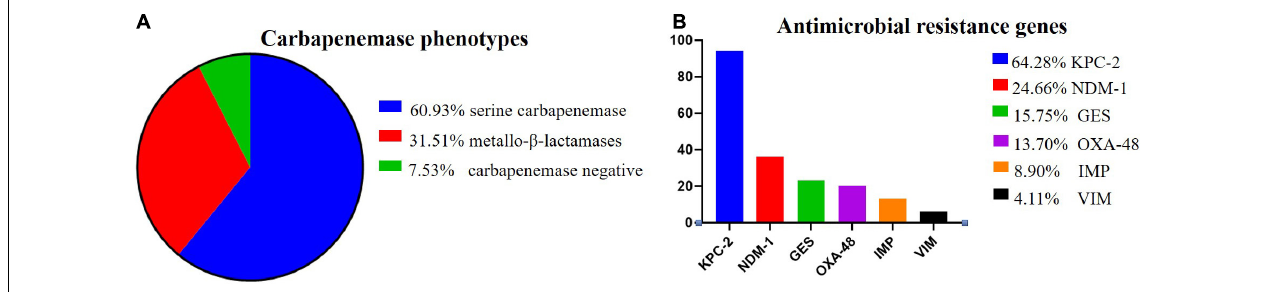
FIGURE 2 | The proportion of carbapenemase phenotypes and antimicrobial resistance genes in CR-KP. (A) Proportion of carbapenemase phenotypes. Colors represent the different carbapenemase, which are arranged from top to bottom. (B) Proportion of antimicrobial resistance genes. Colors represent the different resistance genes, which are arranged from top to bottom. The x- and y-axes represent genes and the number of isolates,